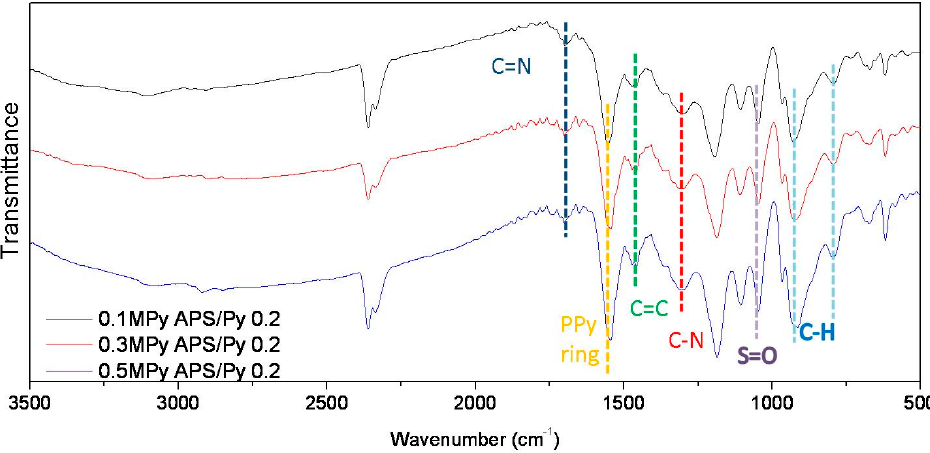
Figure 2. The FT-IR spectra of selected PPy films.